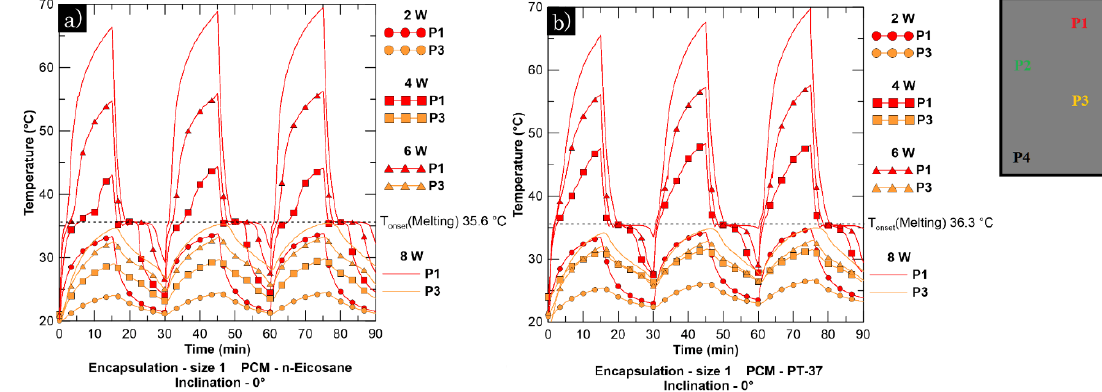
Figure 5. Influence of power input levels on PCM melting for intermittent operation at 0° inclination with Size 1 PCM TES Unit: ( a ) n- eicosane and ( b ) PT-37.